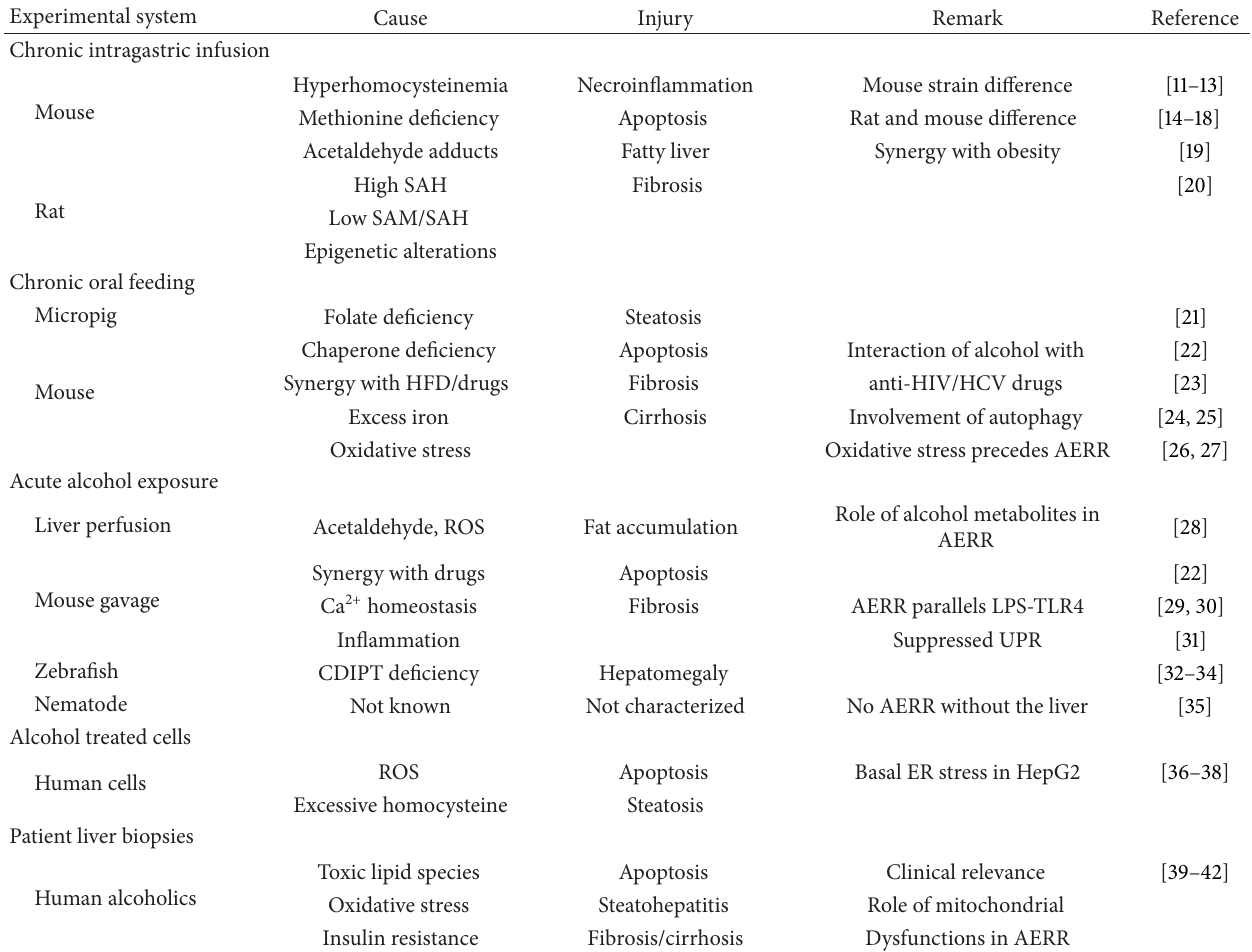
Table 1: Alcohol-induced endoplasmic reticulum stress (AERR) and injuries occur in many species. Experimental